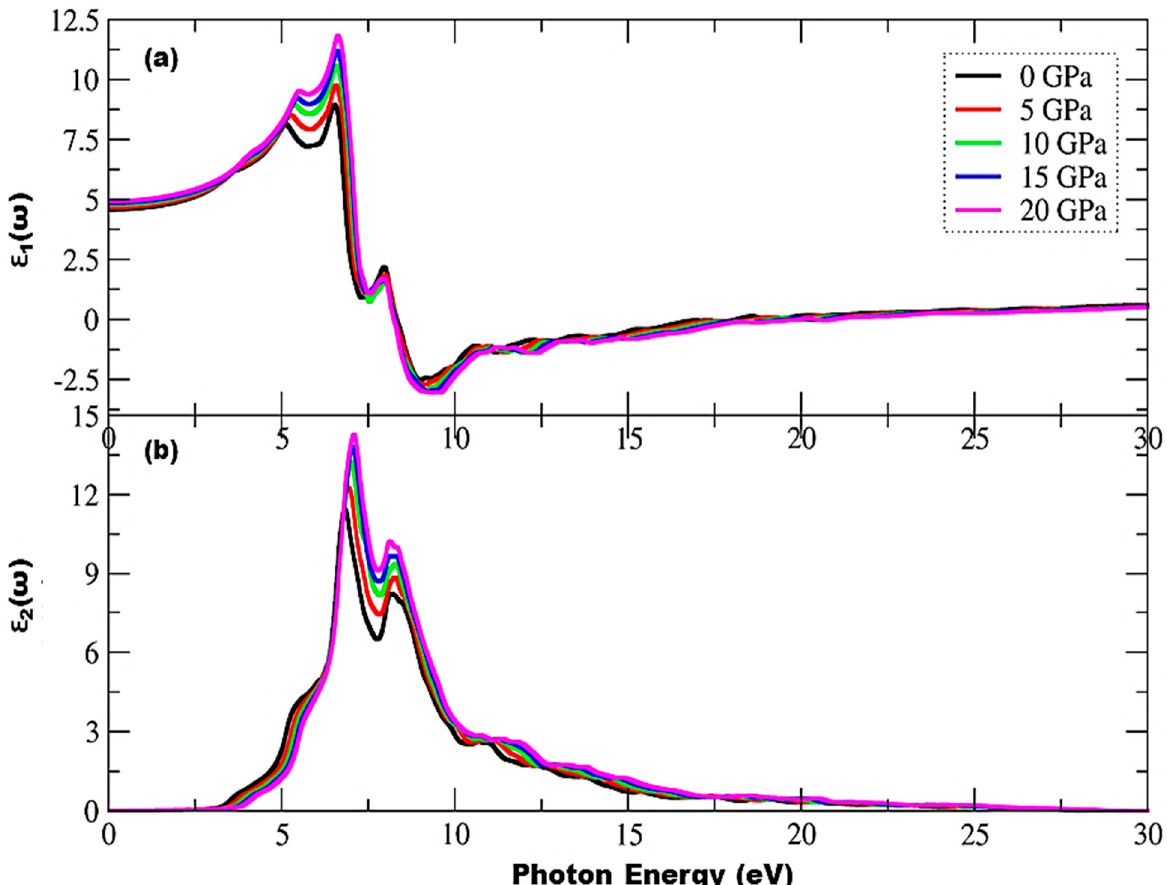
Figure 4. Pressure-induced variations in a complex dielectric function, ( a ) real part, and ( b ) imaginary part.